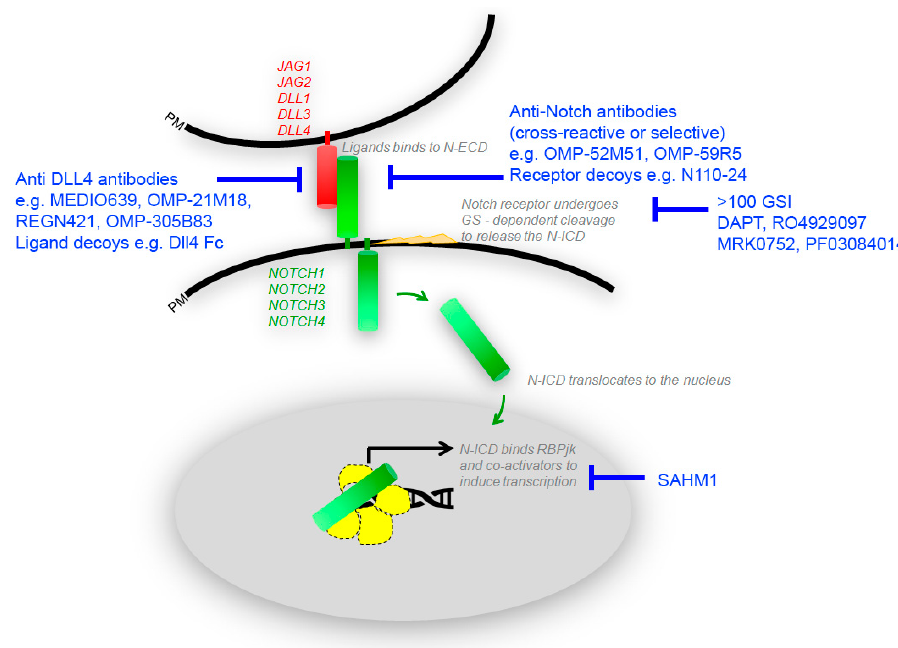
Figure 1. Therapeutic targets in the Notch signaling pathway. The Notch pathway can be targeted by small molecule Gamma Secretase Inhibitors (GSI), antibodies (Anti-Notch, Anti-Dll4), decoys, and